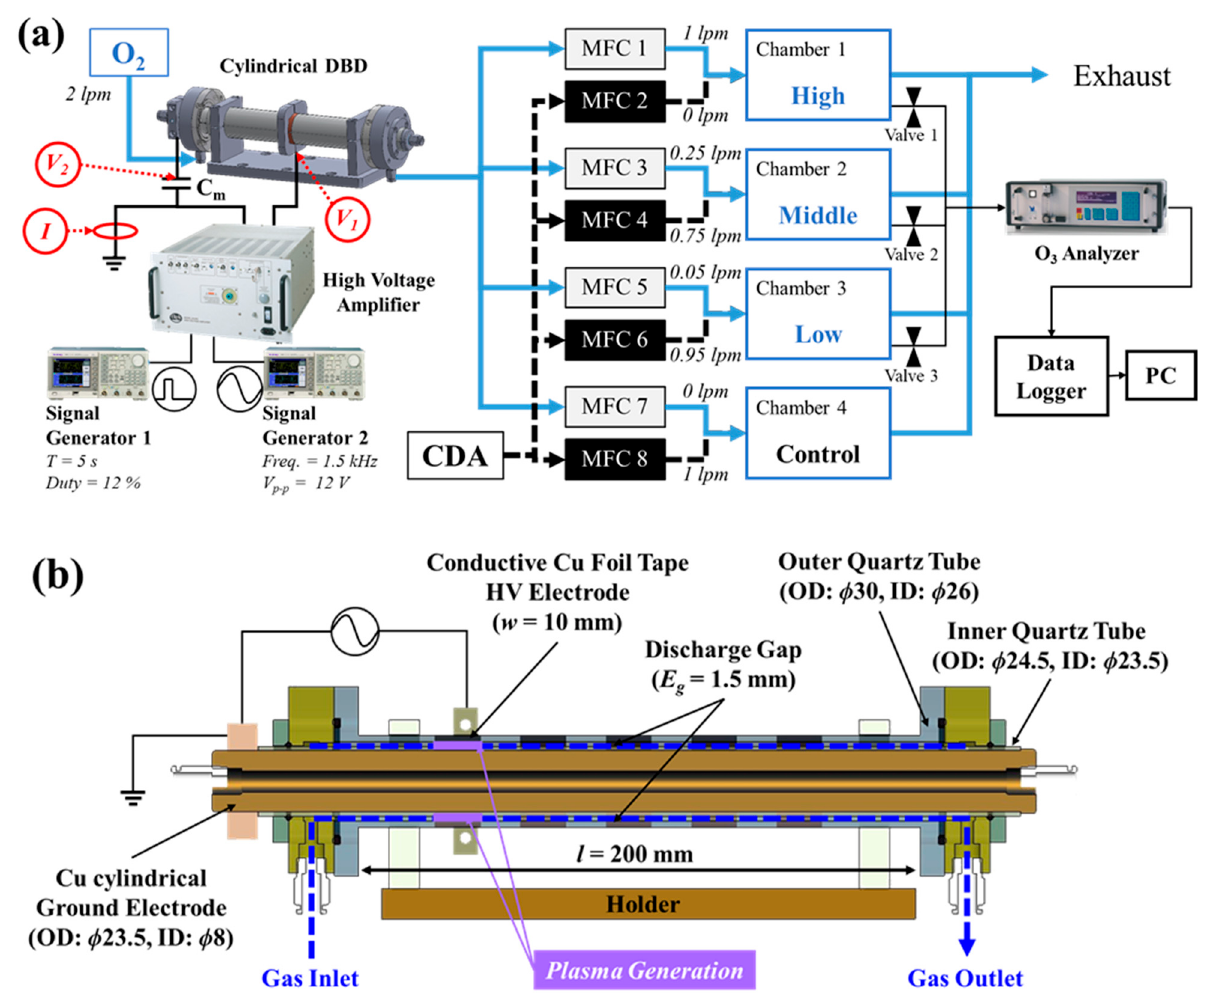
Figure 1. ( a ) Cylindrical atmospheric pressure DBD plasma source installed gas distribution system for residual fludioxonil reduction and ( b ) Vertical cross-section diagram of cylindrical DBD plasma source used in this study.